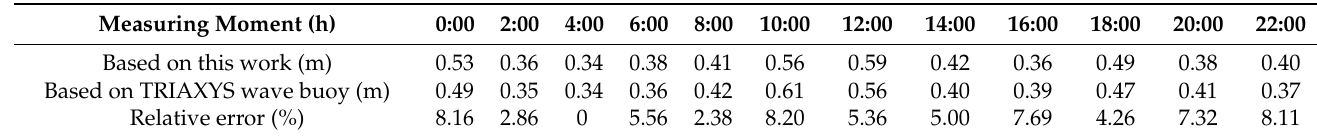
Table 6. Experimental results of wave